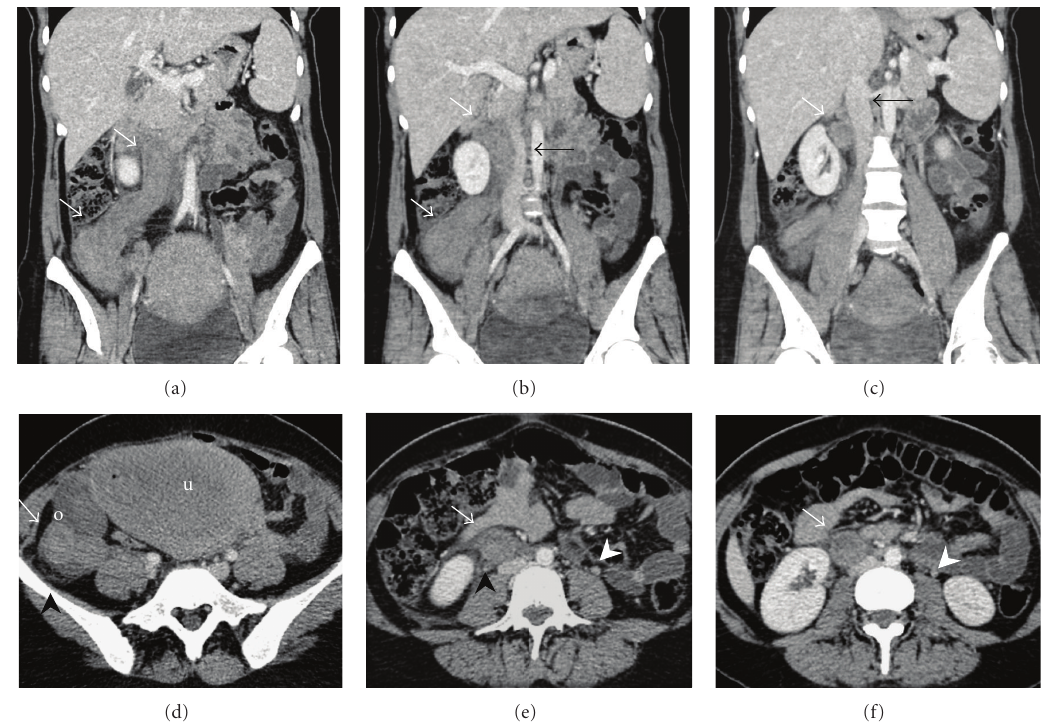
Figure 2: Coronal ((a)–(c)) and axial ((d)–(f)) contrast-enhanced multidetector computerized tomography (MDCT) images demonstrate an enlarged ovarian vein with central hypodensity, representing complete thrombosis (white arrows) extending up to the inferior vena cava, ending at the right renal hilus. There is also surrounding perivascular inflammatory reaction (black arrow heads). Note inflammatory changes in retroperitoneal fat around ovarian vein. Iliac vein is patent. The other ovarian vein is normal in calibration (white arrow